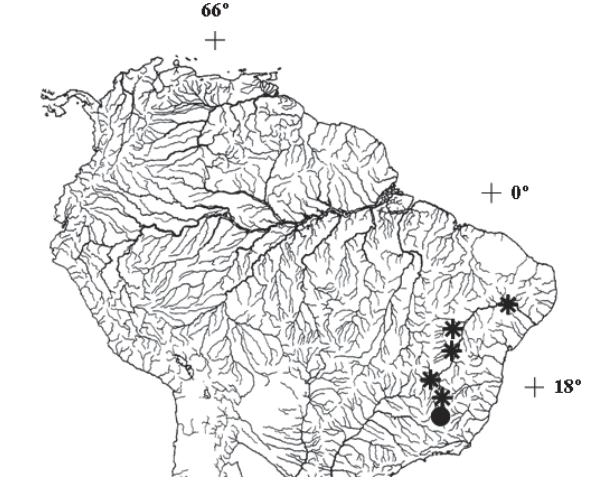
Fig. 3 . Distribution of Pimelodus pohli (stars). Type-locality (circle). Symbols can represent more than one